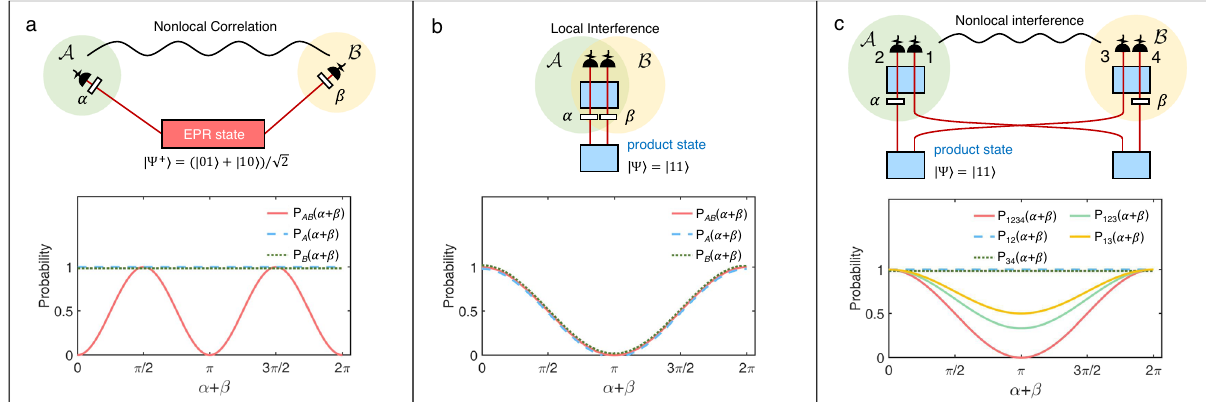
Fig. 1 | Non-local and local quantum interference. a Non-local quantum inter- of interferenceis local,asthe detectionevent of A willalwaysbeinthe futurelight cone of setting event of B ( β ). c Four-photon frustrated interference shows a non- ference of entangled states. The two photons from one Einstein--Podolsky--Rose- n(EPR) state source (red rectangle) have correlations that persist even when two observers measure their respective photons at a distance from each other. The + 1 cos ð α + β Þ (redsolidcurveinthe dependsonbothphases α and β : P 1234 ð α + β Þ = 1 coincidence of Alice ( A ) and Bob ( B ) depends on the angles of the polarizer 2 2 lower panel of Fig. 1c). The local measurement of A / B (two-photon coincidence) transmissionaxis, α and β : P AB ð α + β Þ =sin 2 ð α + β Þ (redsolidcurveinthelowerpanel of Fig. 1a). All the probabilities in these fi gures are normalized with the maximum shows no interference when varying α and β : P 12 ( α + β )= P 34 ( α + β )=1 (blue dash/ greendotcurveinthelowerpanelofFig.1a).Thethree-foldcoincidencecountof countingrateforallthepossiblemeasurementsettings.Thesinglecountsof A and B (bluedash/greendotcurveinFig.1a)shownointerferencewhenvarying α and β : P A ð α + β Þ = P B ð α + β Þ =1. b Two-photonfrustratedinterference.Onepairofphotons is generated from one of the two product-state sources (blue rectangles). These two possible photon-generation processes interfere when they are indistinguish- able.Theprobabilitiesofdetectingtwophotons(redsolidcurveinthelowerpanel of Fig. 1b) and single photons(blue dash/green dotcurve inFig.1b) depend onthe + 1 cos ð α + β Þ . This type phases in the system: P AB ð α + β Þ = P A ð α + β Þ = P B ð α + β Þ = 1 2 2